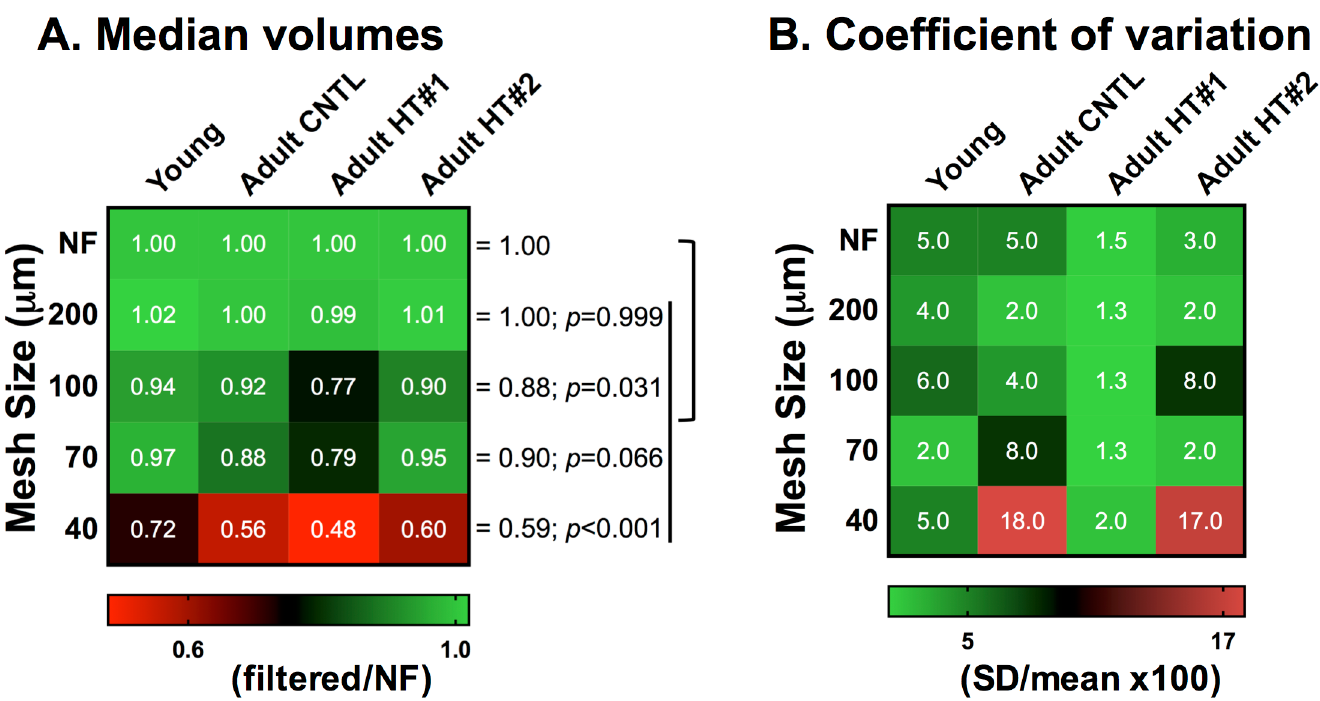
Fig 2. Variability in myocyte volumes. A, Myocyte volumes for filtered samples from each ventriclewere normalizedto the correspondingnot-filtered (NF) volume (top row). Heat map values represent the fold change in medianvolume for each mesh size when comparedto NF VMs. A 1.00 (lighter green) means no changein volume betweenthe filtered and NF sample for each animal. The p values are calculatedby one-wayANOVA among mesh size groups, and group to group comparisons betweenthe NF VMs and each other mesh size were donewith Tukey’s multiple comparison’s test. B, The coefficient of variation(%CV) is a measurement of imprecision that is calculatedby dividingthe standard deviationof identicalreplicates by the mean volume and multiplied by 100. The %CV is calculatedfor each ventricleper mesh using the replicateswithin sample (n = 3–6). A CV (cid:20) 5% (lighter green) is considered optimalfor best assay